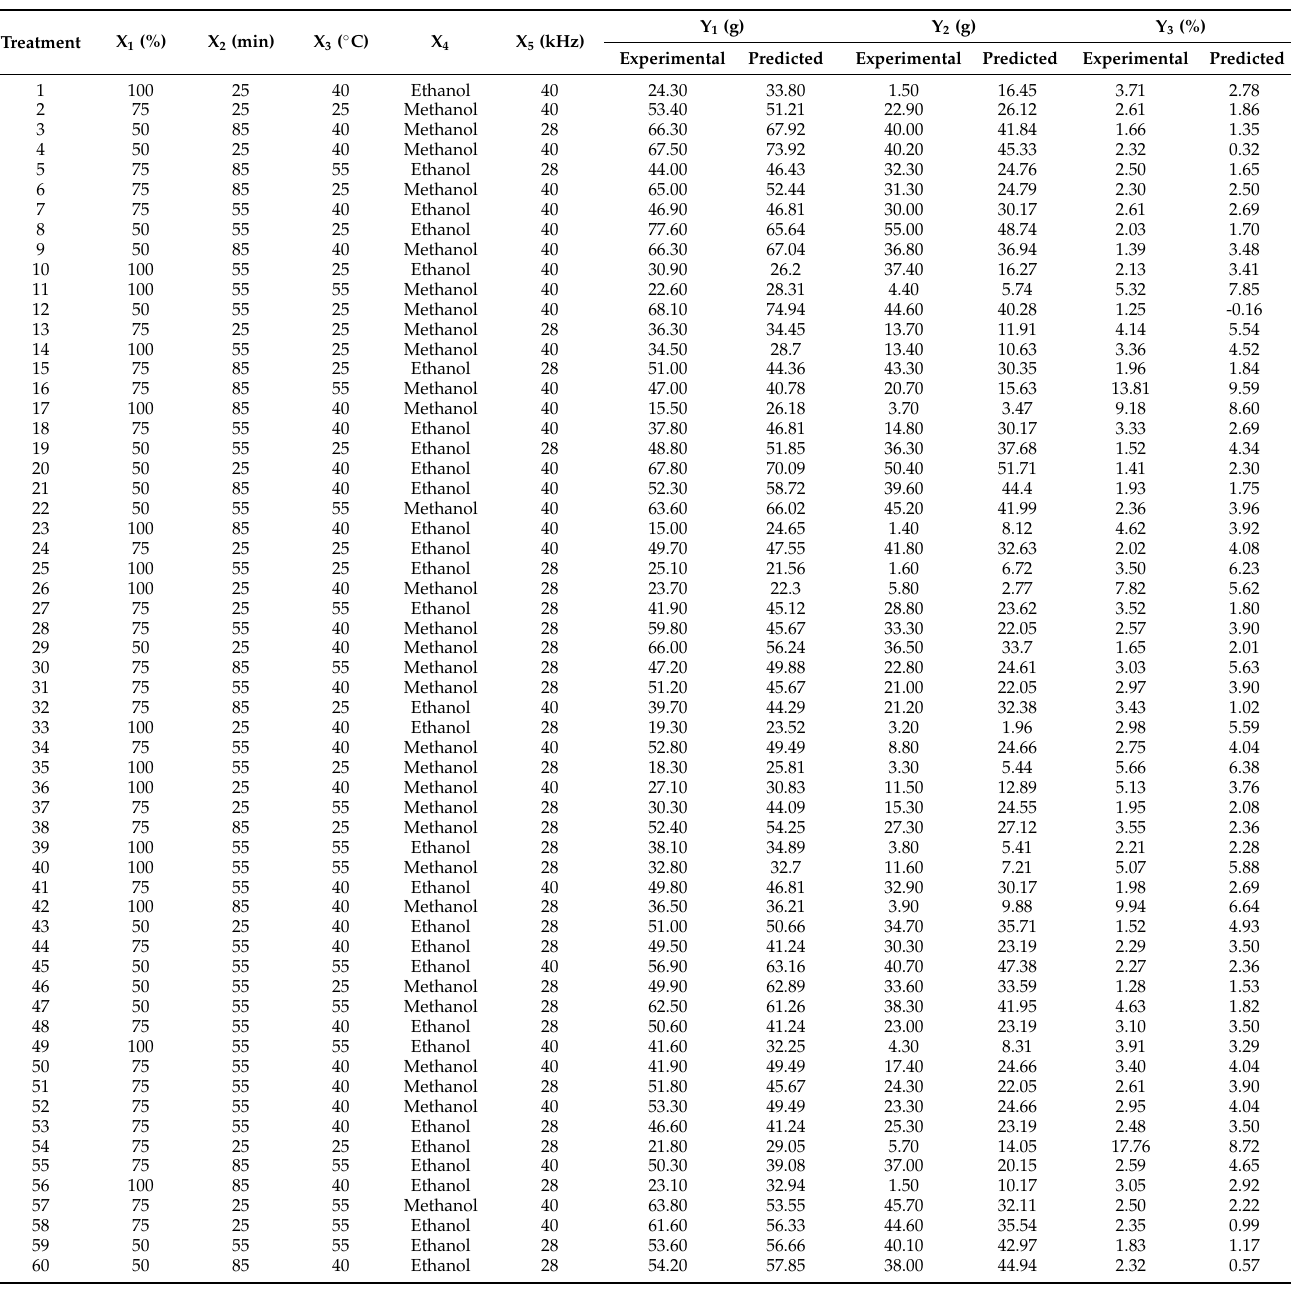
Table 2. Matrix of Box-Behnken design for treatment combinations and the response of crude extraction, sediments after evaporation and left overnight, and the yield of the